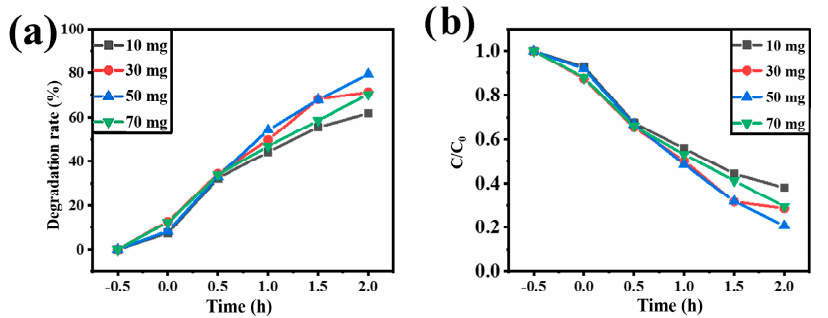
Figure 7. ( a ) Curves of the degradation rate of RhB with different dosages of Zn 0.2 Cd 0.8 S@CD photocatalyst over time; ( b ) concentration curves of RhB with different dosages of Zn 0.2 Cd 0.8 S@CDs photocatalyst over time.